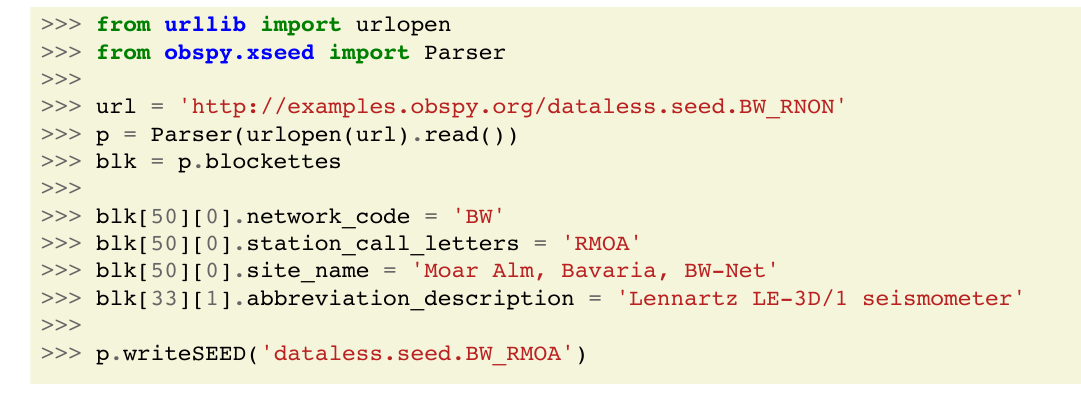
Figure 10. Example code: Reading a Dataless SEED file, changing several fields to adapt it to another station, and writing the new Dataless SEED